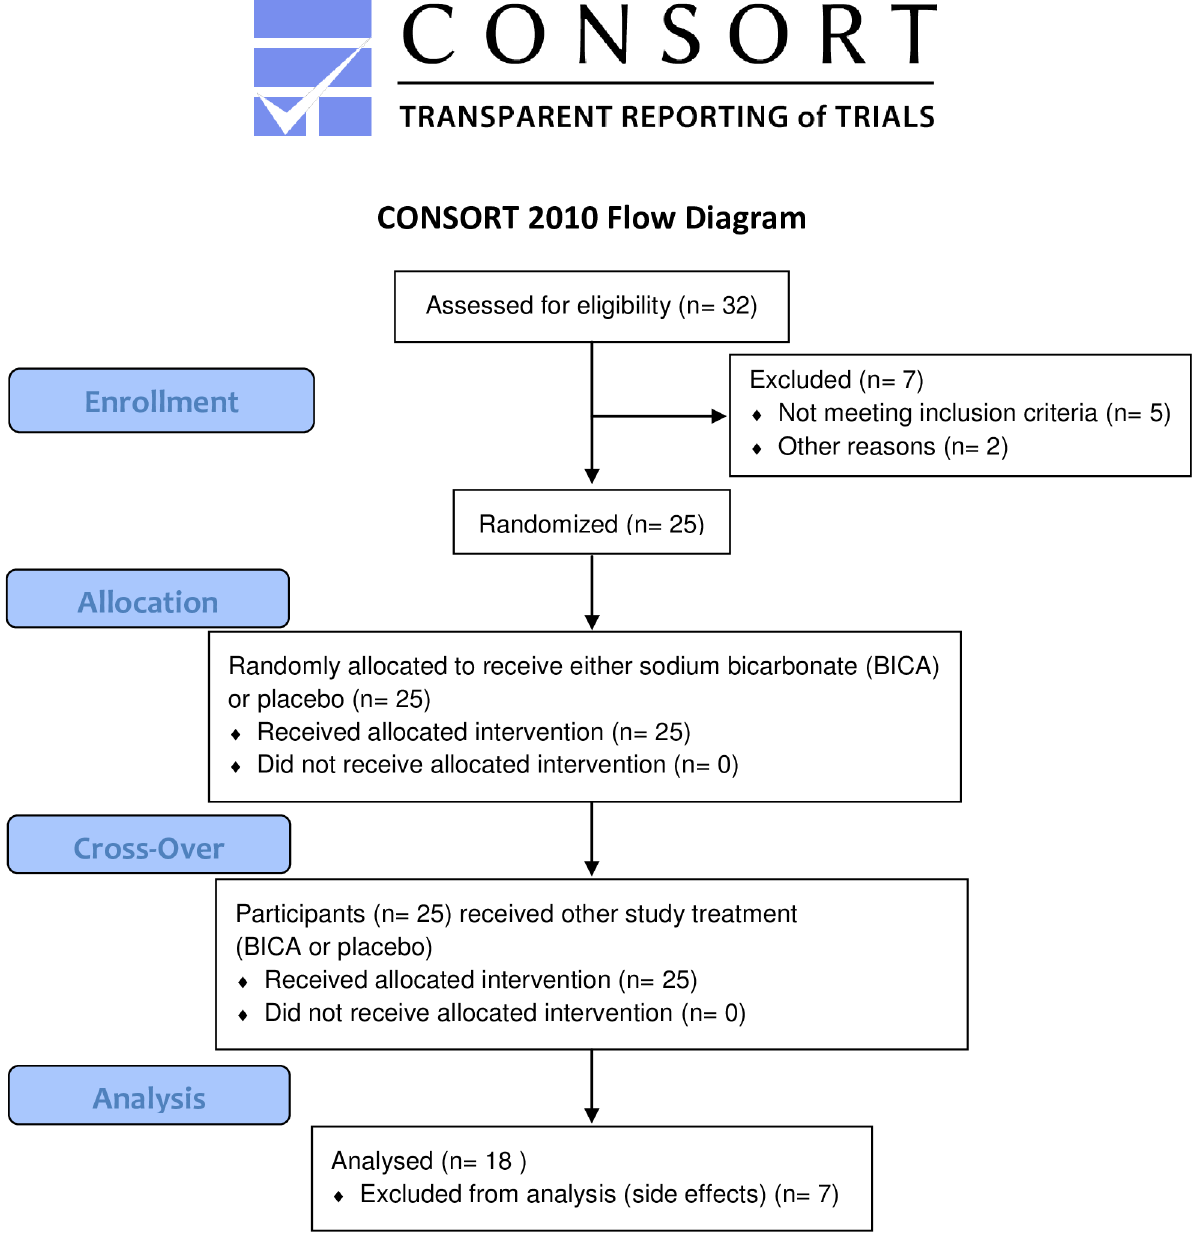
Fig 1. Flow diagram of the